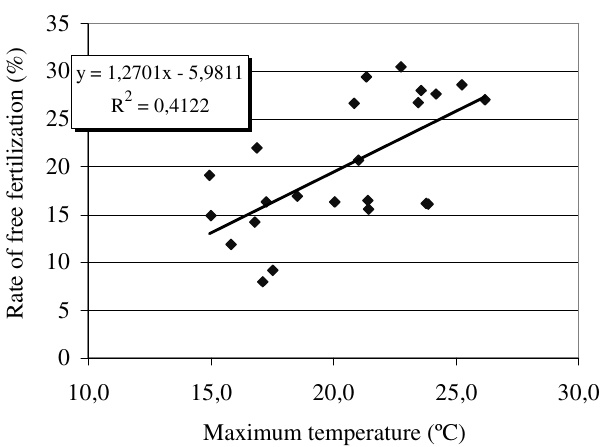
Figure 3: Relationship between free fertilization and amount of sunshine duration during the blooming period at “Újfehértó fürtös” sour cherry